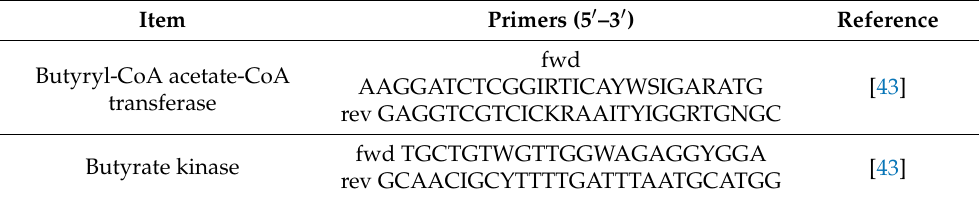
Table 1. Primers used in the present study.